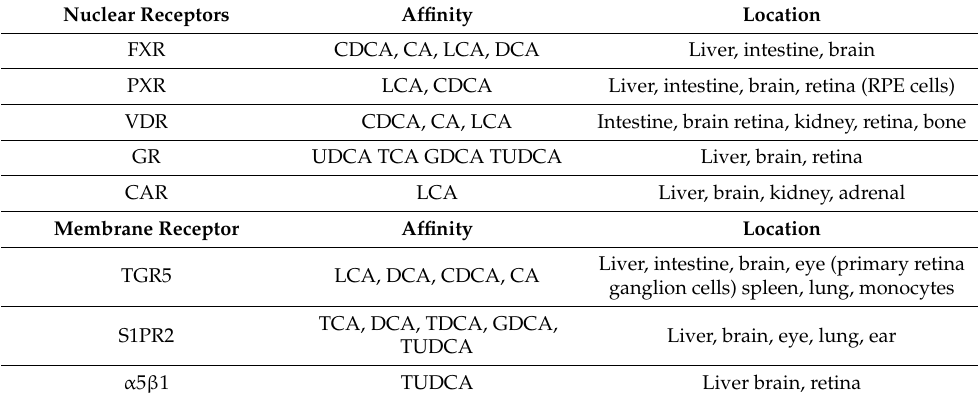
Table 1. Reported bile acid (BA) receptors expression in various